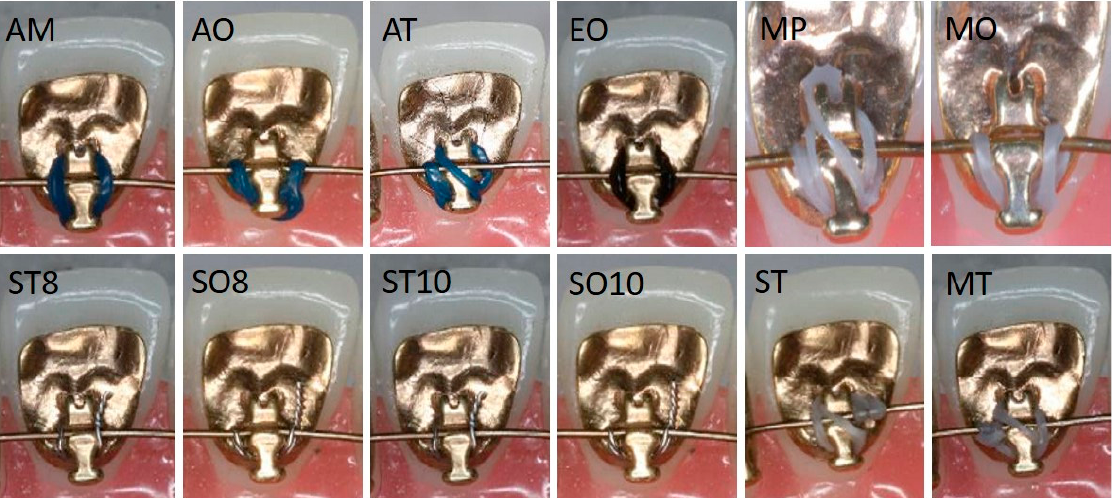
Figure 2. Overview of the different types of ligatures. AM: Alastik module, AO: Alastik over tie, AT: Alastik tipping tie, EO: EasyOn, MT: modified tipping tie, MO: Morita over tie, MP: Morita power tie, ST8: steel tie (0.008 inch), ST10: steel tie (0.010 inch), SO8: steel over tie (0.008 inch), SO10: steel over tie (0.010 inch), ST: Sugiyama tipping tie. Table 1. Overview of the employed different ligation types.